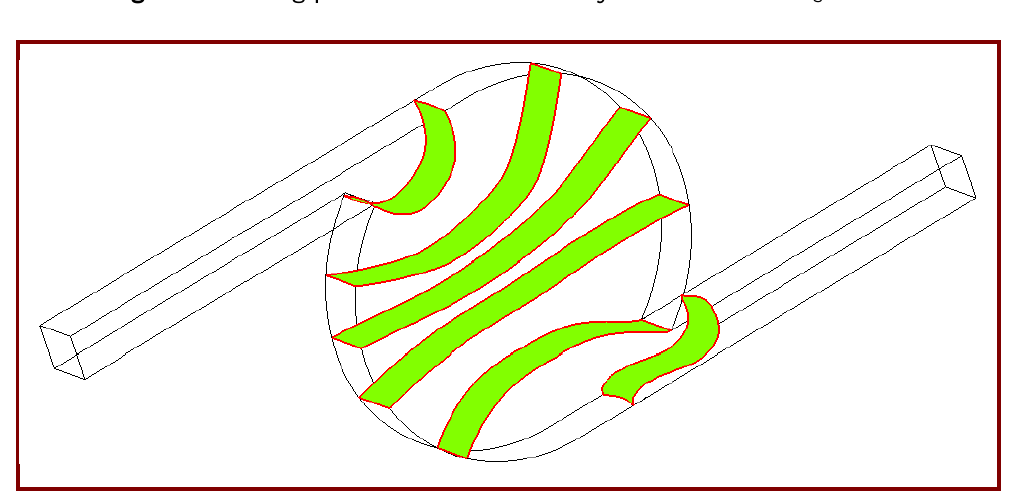
Figure 6. Filling process for inlet velocity of 0.5 m/s and θ